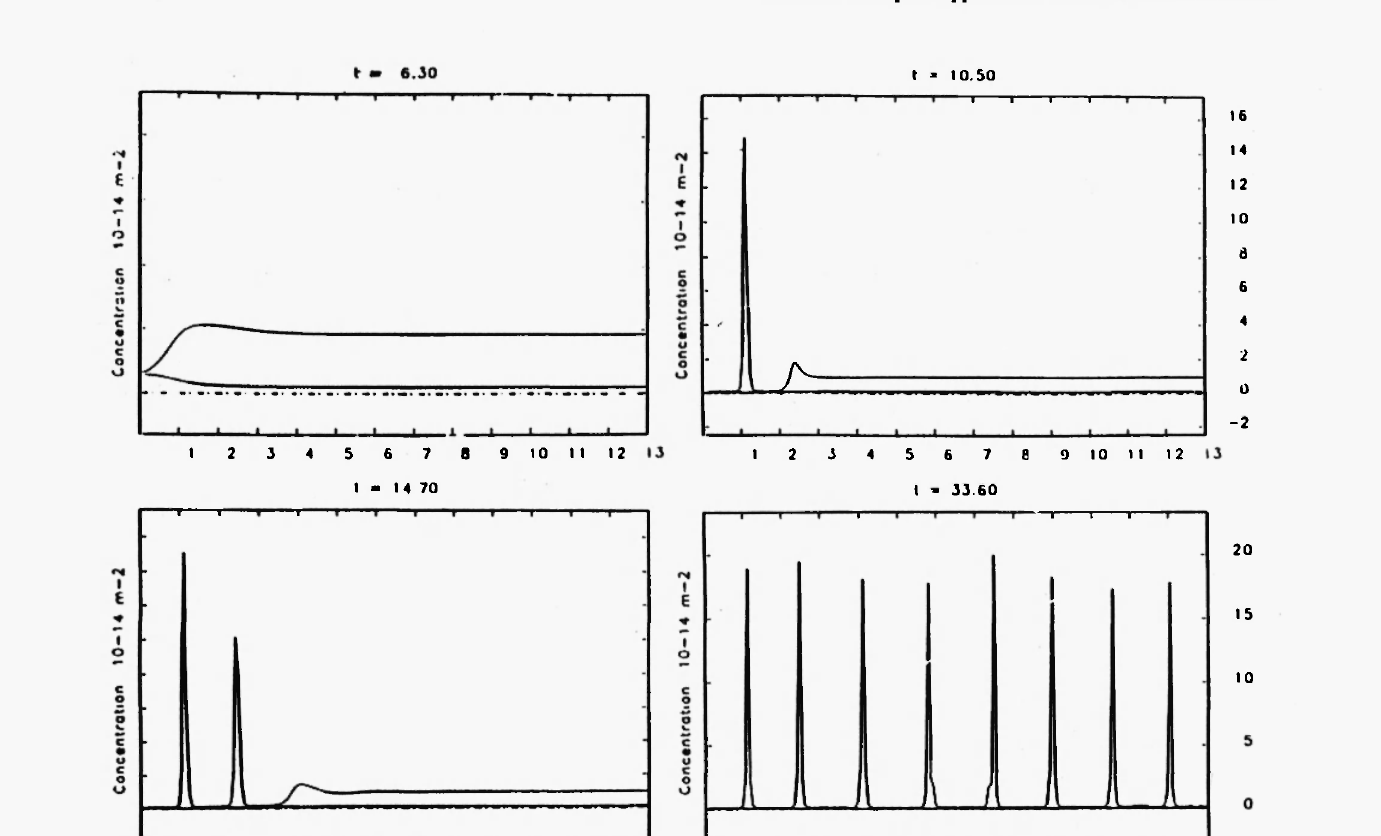
Figure 2: The development of a wall structure from a stress inhomogeneity at the left border of the sample obtained by the numerical integration of the reaction-diffusion model (1). The figure shows snapshots of the time evolution of the free and trapped dislocation densities in space (the time is given in periods of the fatigue process, e = 3.5, other parameters and details are given in